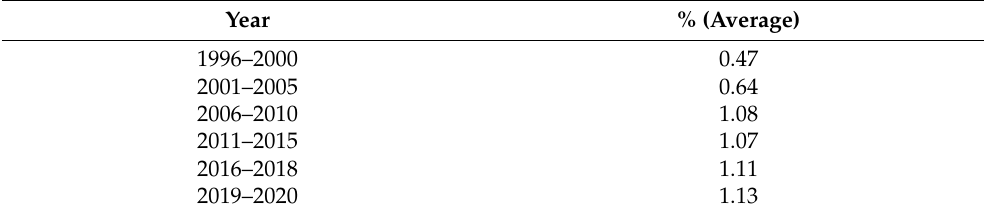
Table 1. Ratio mass of NdFeB magnets/mass of mobile phones over the years, as a